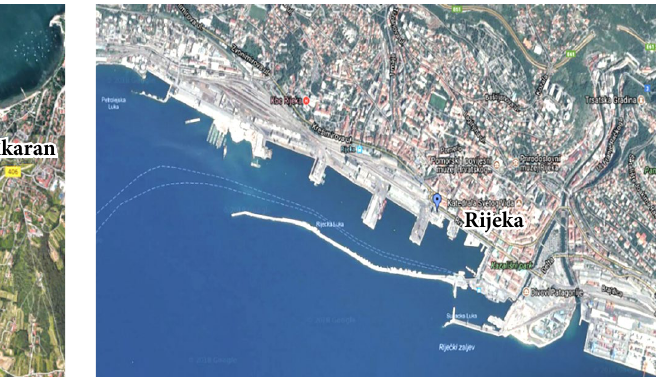
Figure 3. Port of Koper and the cities of Koper and Ankaran ( https: // www.google.com / maps )